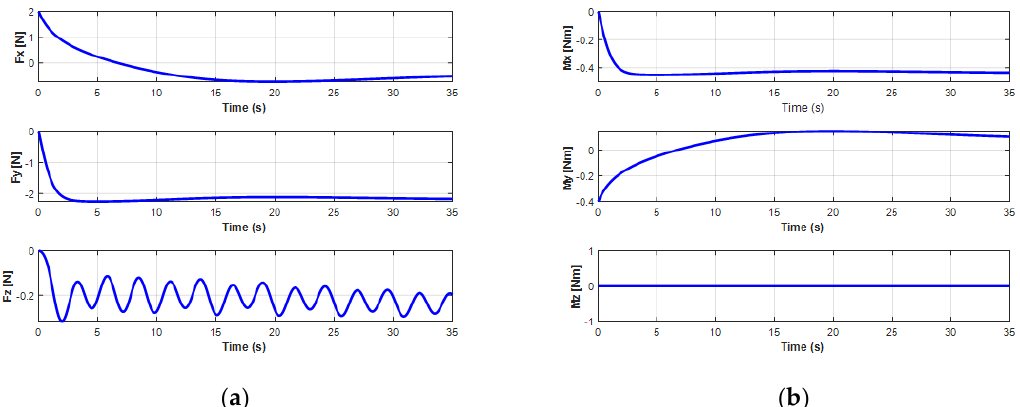
Figure 28. Cable forces and moments effecting to the UUV doing the sideward motion: ( a ) forces of the UC on the UUV; ( b ) moments of the UC on the UUV.